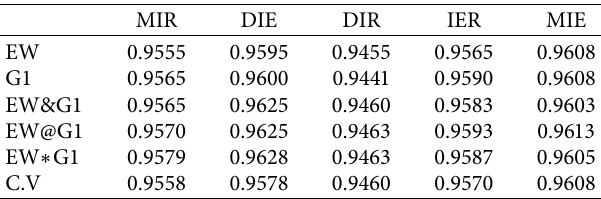
Figure 4: Comparative experiment of the fsh data set. Table 2: Fish data